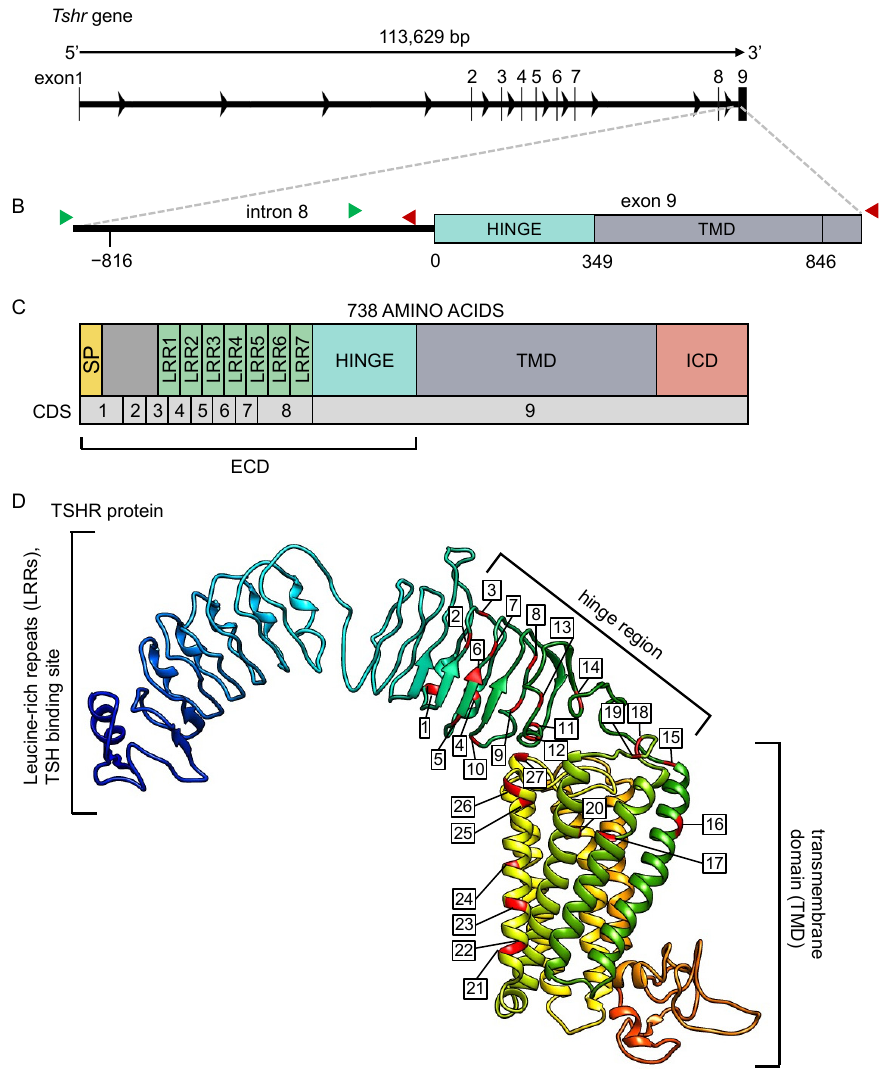
Figure 2. The Tshr gene and predicted protein for the common vole. ( A ) The Tshr gene for the common vole, consisting of 8 introns and 9 exons. ( B ) The magnified region, including the last part of intron 8 and the first part of exon 9, were sequenced in this study. Green arrows indicate location of forward primers, and red arrows indicate location of reverse primers for sequencing. ( C ) The predicted TSHR protein and ( D ) its 3D structure. All mutations found in the current study are labeled and listed in Tables S4–S7. SP = signal peptide, LRR = leucine-rich repeat, TMD = transmembrane domain, ICD = intracellular domain, ECD = extracellular domain, CDS = coding